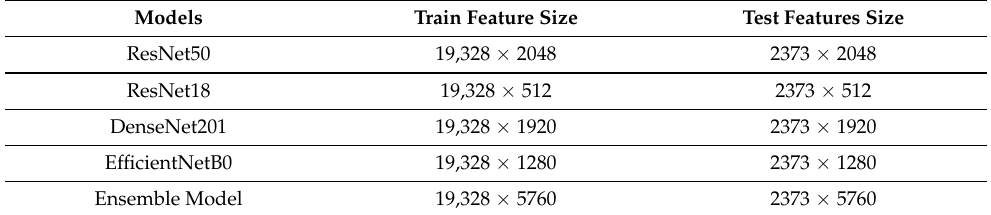
Figure 14. Coding matrix for the eight classes of breast cancer. Table 5. Detail distribution of the dataset and features